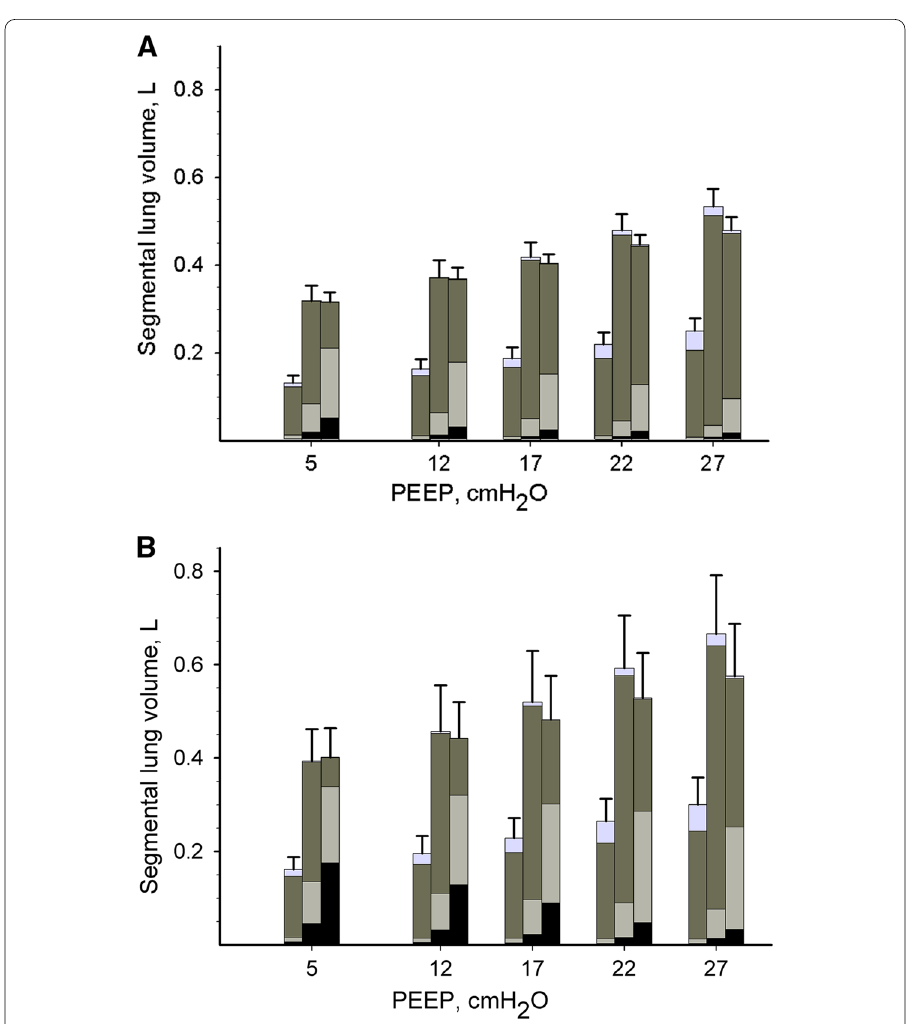
Fig. 1 Effect of descending positive end expiratory pressure (PEEP) level on end‑expiratory segmental lung volumes measured by computed tomography with healthy lungs ( a ) and after creating lung injury ( b ). Abdomen was inflated to an intra‑abdominal pressure of 27 cmH 2 O (20 mmHg). Three lung segments are depicted at each condition with left to right representing ventral, medial and dorsal lung segment, respectively. Segmental lung volumes are a composite of overdistended (light grey, normally aerated (dark grey, 900 to 501 HU), poorly aerated (light grey third from top, − − and non‑aerated atelectatic lung (black, 100 to 200 HU). Mean and SE are shown. See Table 1 for statistical −